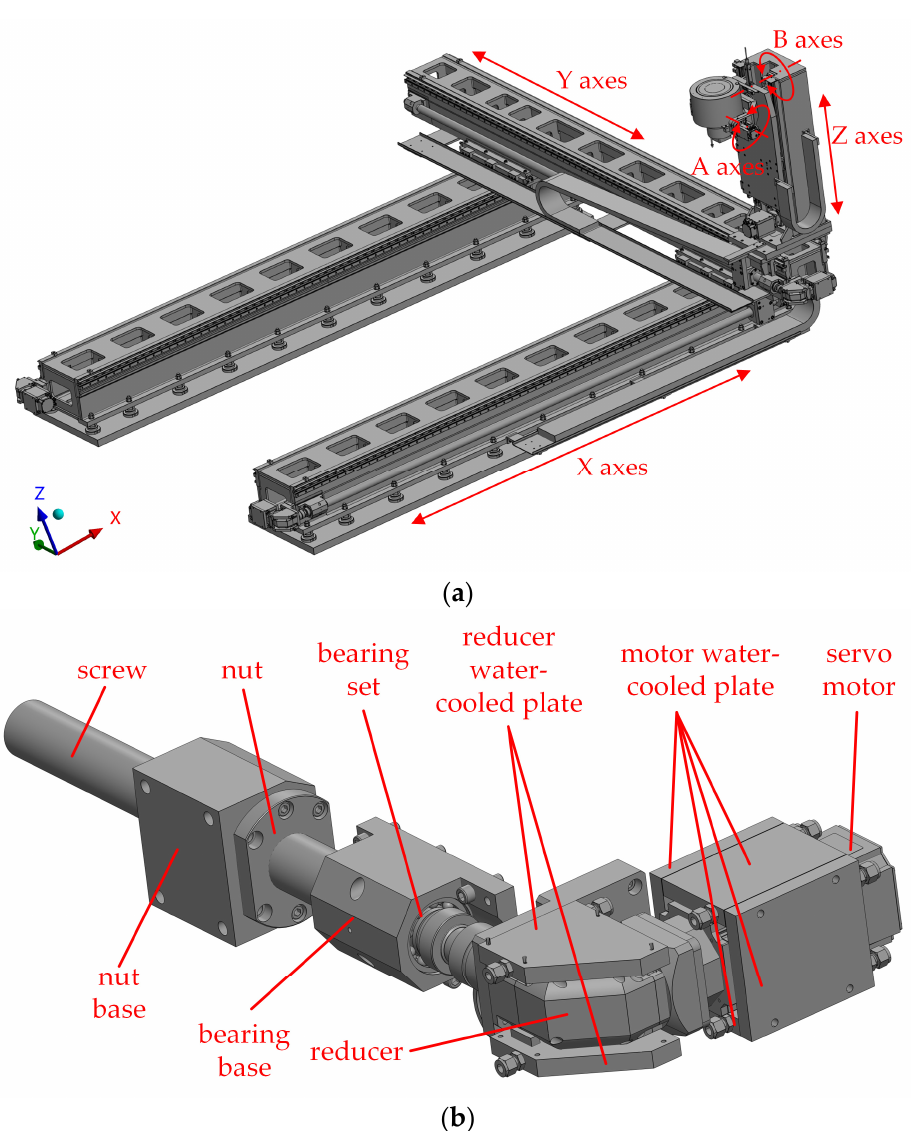
Figure 1. 3D model of the whole machine and the components of the translation shaft: ( a ) 3D model of the whole machine; ( b ) Components of the translation shaft.